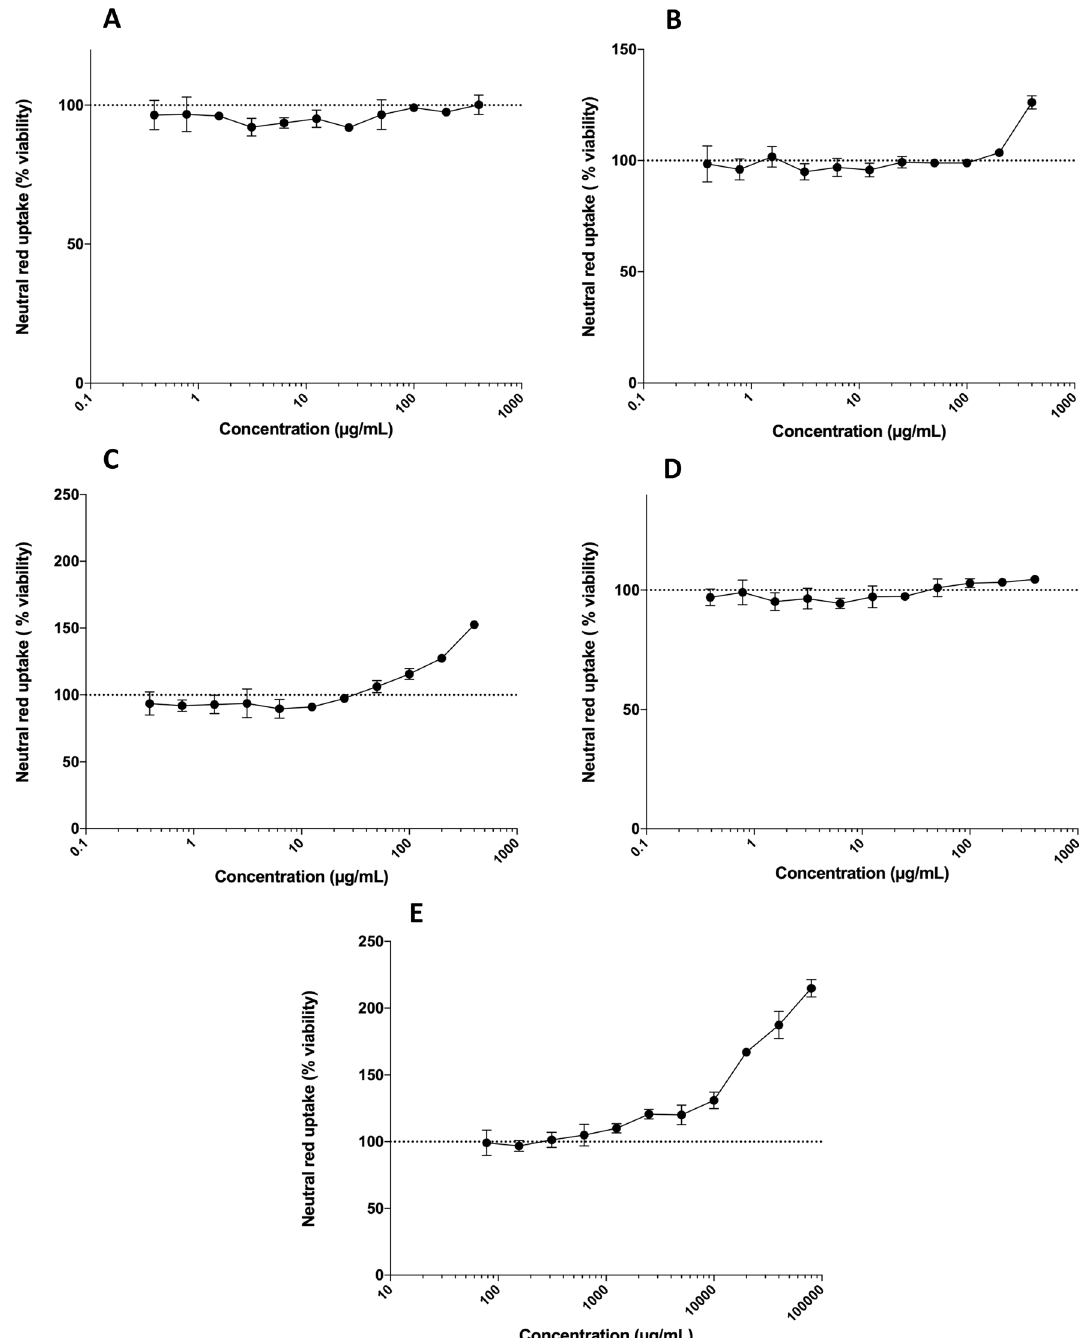
Figure 3. The effect of increasing concentrations of ( A ) MccJ25 ( B ) Pediocin PA-1 ( C ) Bactofencin A ( D ) Nisin, and ( E ) Reuterin on the viability of NHEK cells after 24 h of exposure using the neutral red assay. Viability is presented as a percentage of total cell viability. The control represents 100% viability. Concentration range for reuterin was 0.8–80 mg/mL and for other bacteriocins 0.4–400 μg/mL. Error bars show the standard error of mean (n =